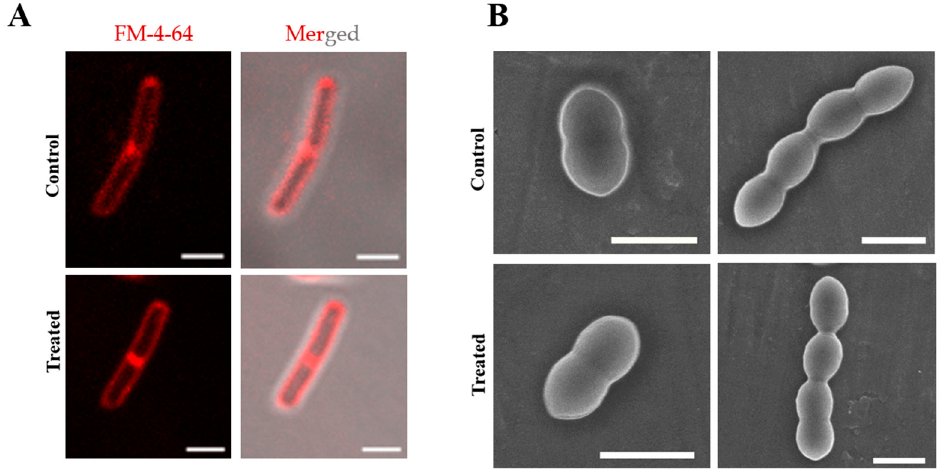
Figure 5. Enol 3 has no effect on the membrane or morphology of B. subtilis and S. pneumoniae cells. ( A ) Fluorescence (FM-4-64 channel) and DIC-merged laser scanning confocal microscopy images of Bacillus subtilis 168 cells stained for membrane using FM-4-64 dye after treatment with and without 8 µM 3 for 10 min. The images are representative of 300 cells imaged in each case. Scale bar indicates 2 µm. ( B ) Scanning electron microscopy images of fixed S. pneumoniae TIGR4 cells treated with, or without, 2 µM 3 for 1 h. The cells shown are representative of 100 cells imaged in each case. Scale bar indicates 2 µm.